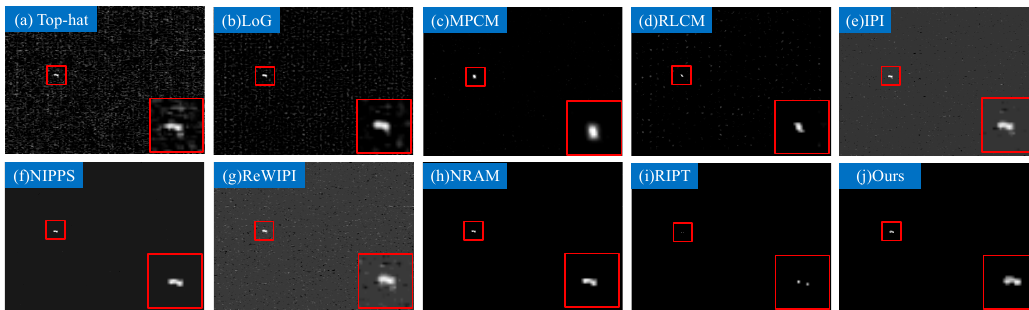
Figure 17. Results of the different approaches to Sequence 3.